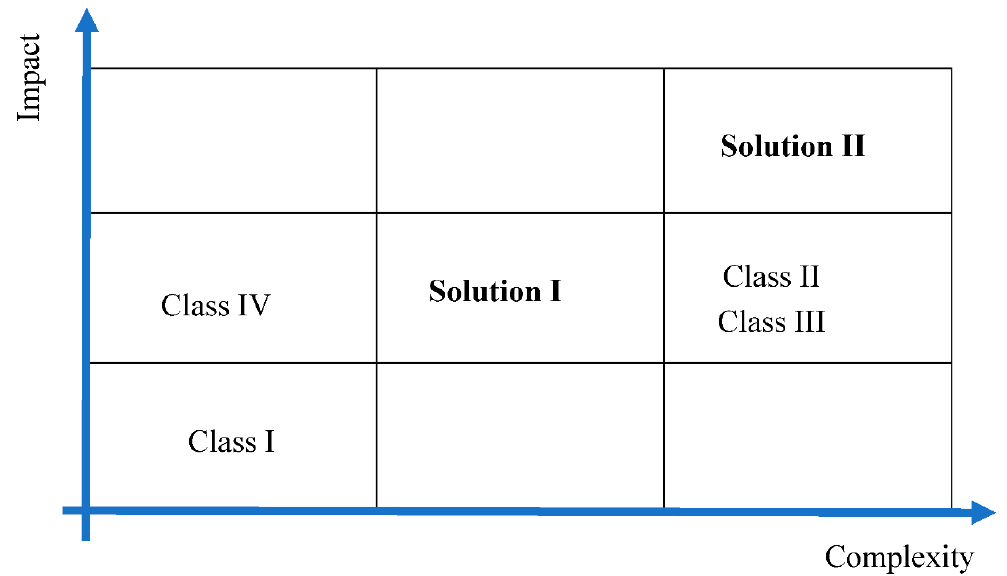
Figure 10. CI analysis of development classes and proposed solutions.